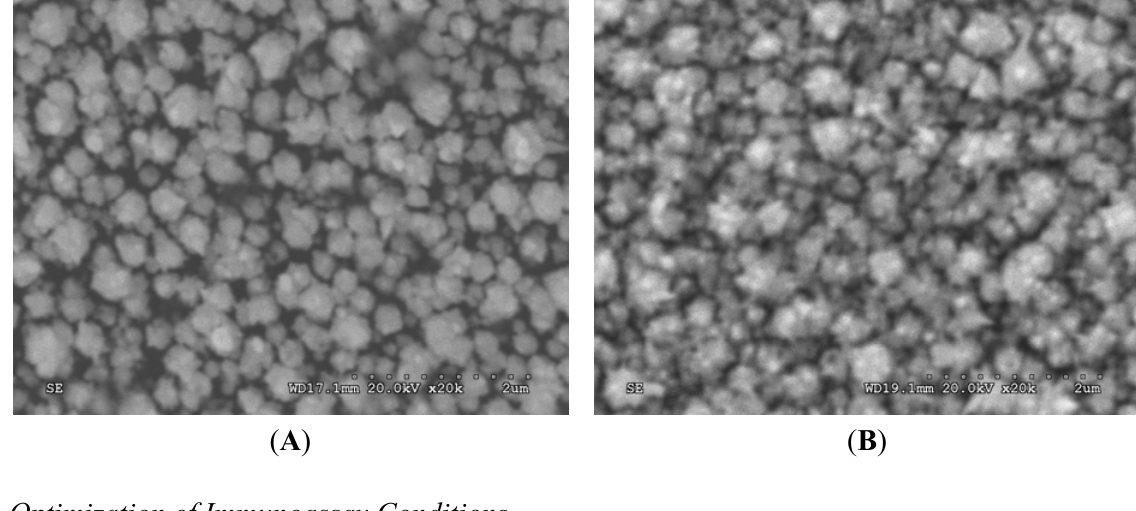
Figure 4. ( A ) Effect of hydroquinone concentration. ( B ) Effect of H